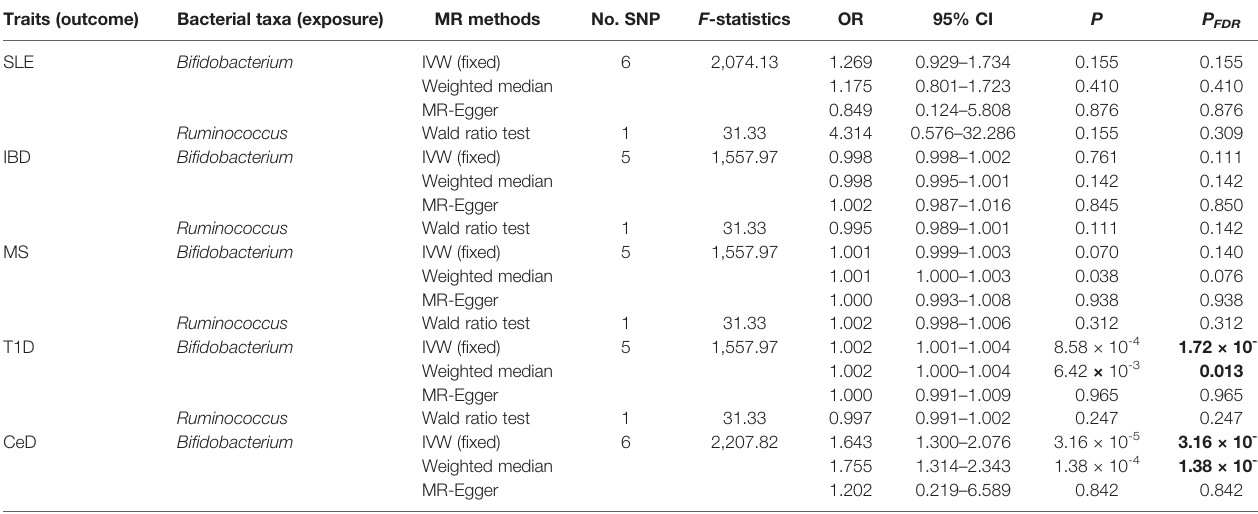
TABLE 3 | Results of the identi fi ed bacterial taxa in the replication samples. Traits (outcome)